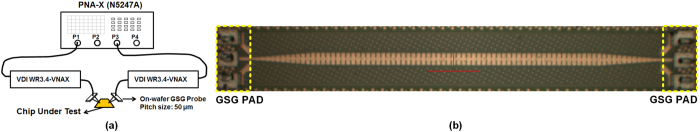
(a) Measurement setup for the (sub)-THz SPP T-line with converter, (b) die micrograph of the proposed SPP T-line with converter in 65 nm CMOS for Terahertzes applications.